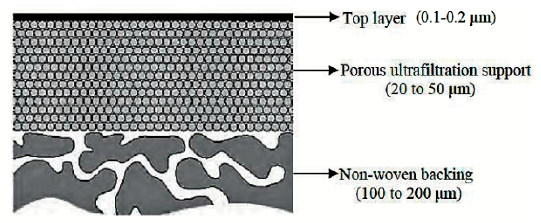
Figure 25. Schematic of TF composite membrane.